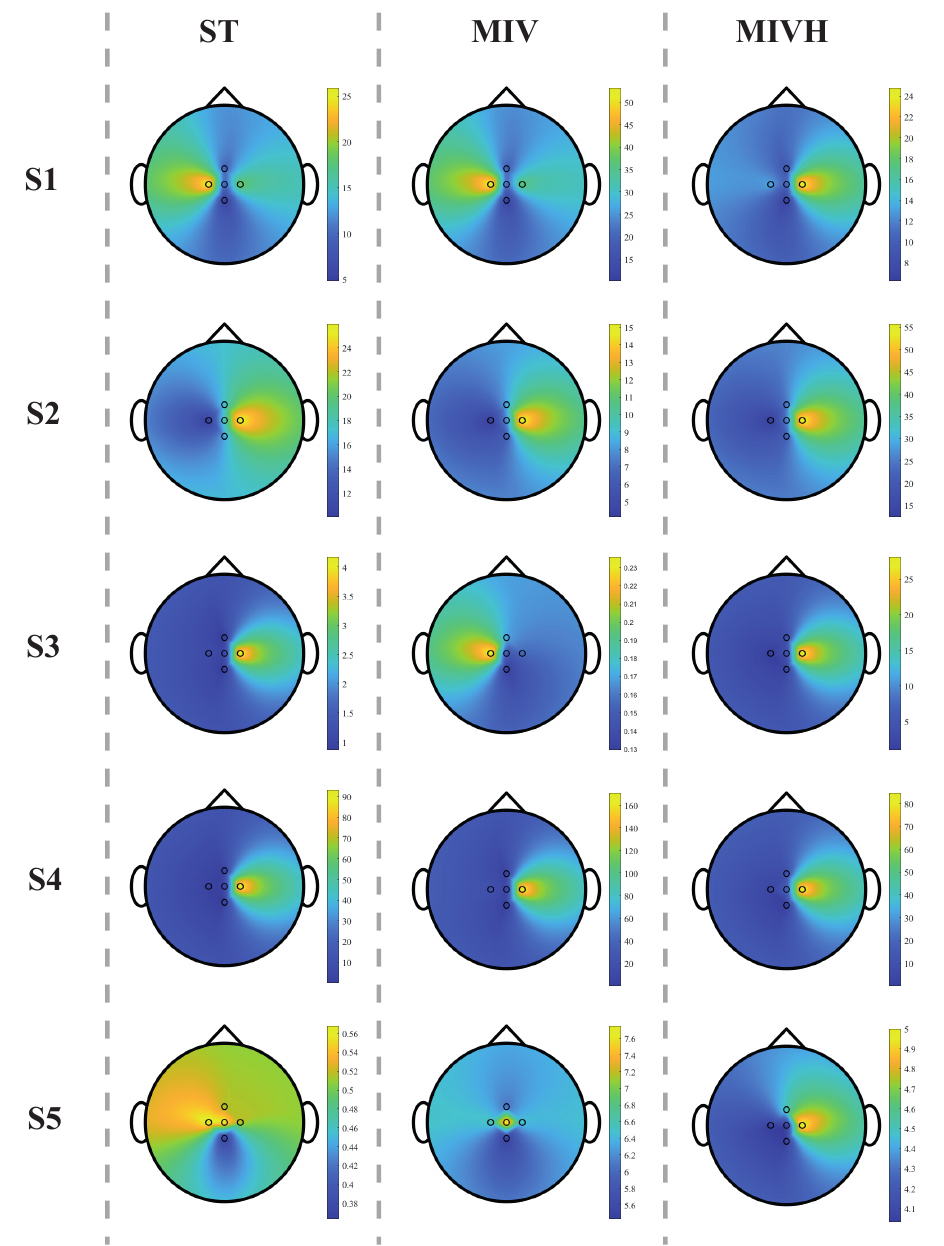
Figure 8. Electroencephalography (EEG) topographies of Power Spectral Density (PSD) associated with the Event-Related Potentials (ERPs) of all patients